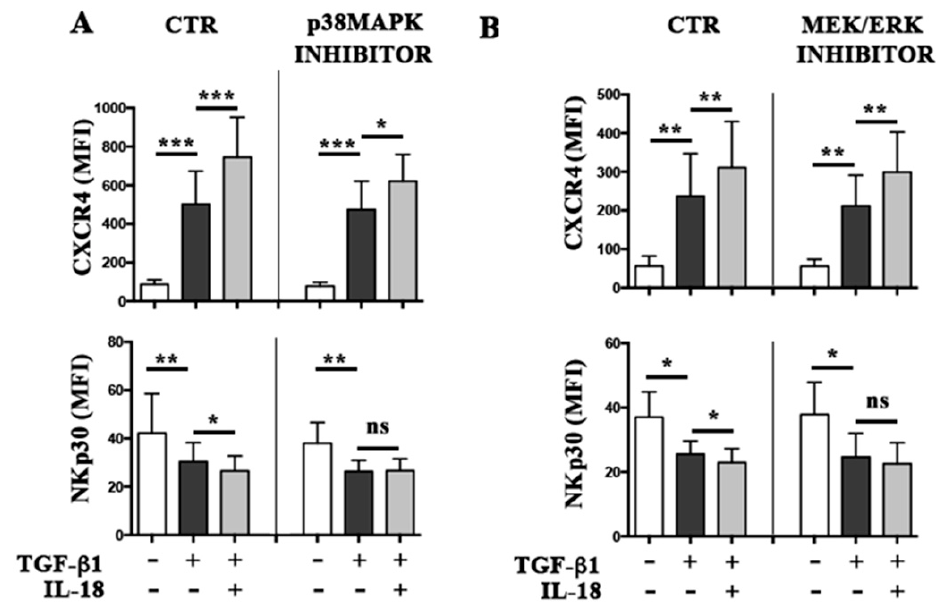
Figure 4. Involvement of p38MAPK or MEK/ERK in the additive effects mediated by IL-18 on TGF- β 1 activity. Cytofluorimetric analysis of CXCR4 and NKp30 surface expression in PB NK cells treated with TGF- β 1 or TGF- β 1 plus IL-18, in the absence or presence of p38MAPK (panel A ) or MEK/ERK (panel B ) inhibitors. Average of four independent experiments (four donors). Mean of MFI and 95% confidence intervals are shown. ns: not significant, * p < 0.05, ** p < 0.01, *** p < 0.001.